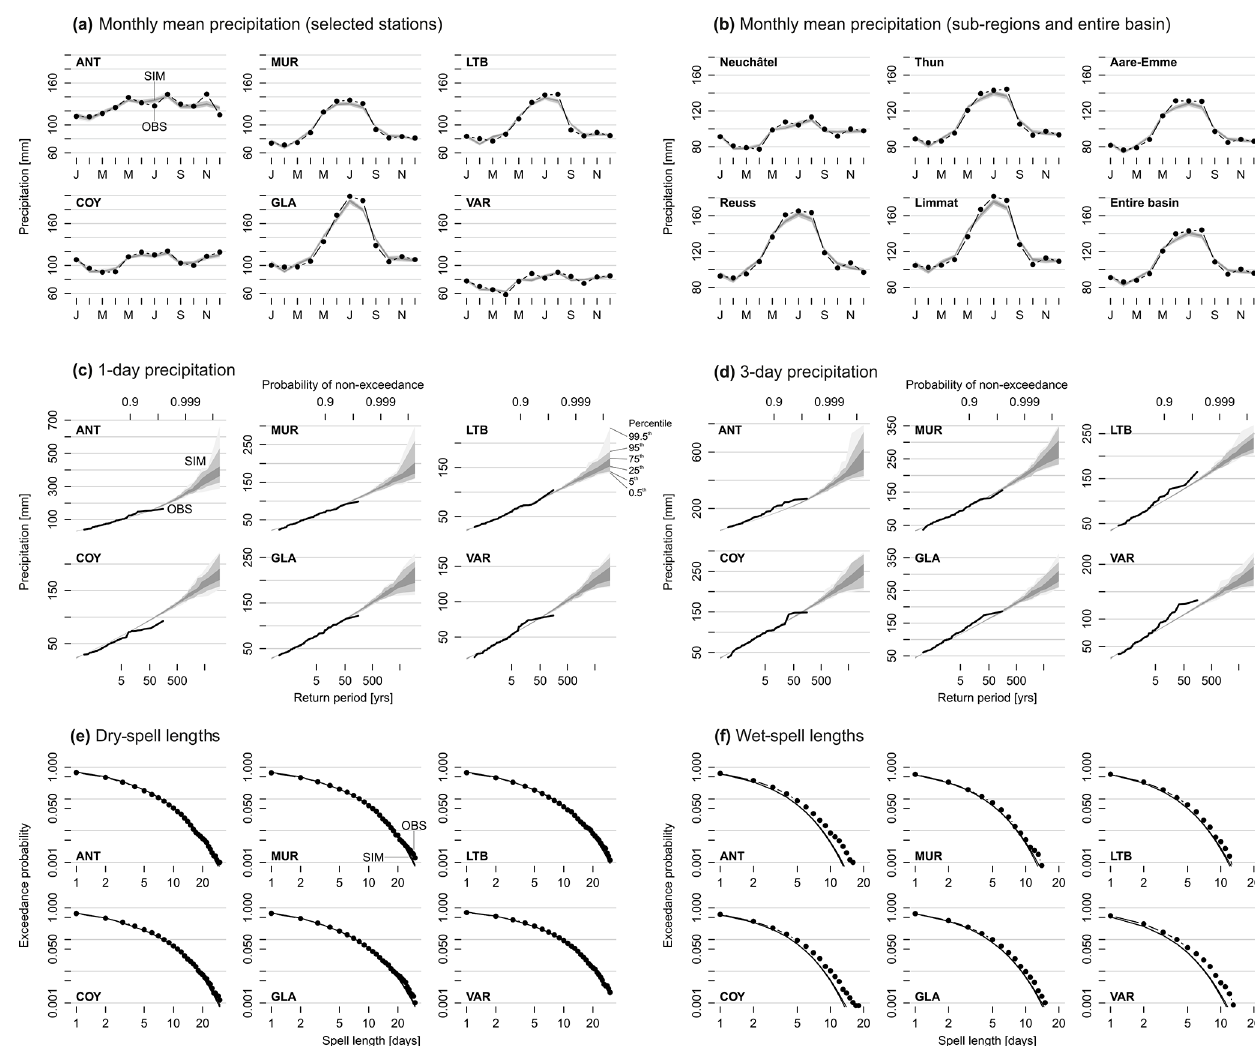
Figure 5. Multiscale evaluation of GWEX regarding monthly mean precipitation (a, b) , 1 and 3d precipitation (c, d) , dry-spell lengths (e) , and wet-spell lengths (f) . Results for panels (a) and (c) – (f) are for six selected representative stations, namely Andermatt (ANT), Muri (MUR), Lauterbrunnen (LTB), Courtelary (COY), Glarus (GLA) and Valeyres-sous-Rances (VAR) (see Table S1); results for panel (b) are for five main sub-regions (see Fig. 10) and the entire Aare River basin. Observations are drawn in black; GWEX results are in